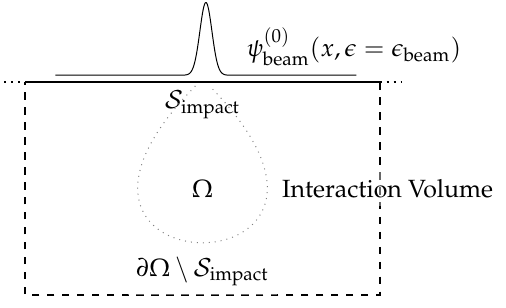
Figure 2. 2D schematic of the domain Ω , the exposed sample surface S impact ( solid line ), the internal surfaces ( dashed lines ), the interaction volume ( dotted line ), and the beams’ spatial distribution ( 0 ) ψ beam